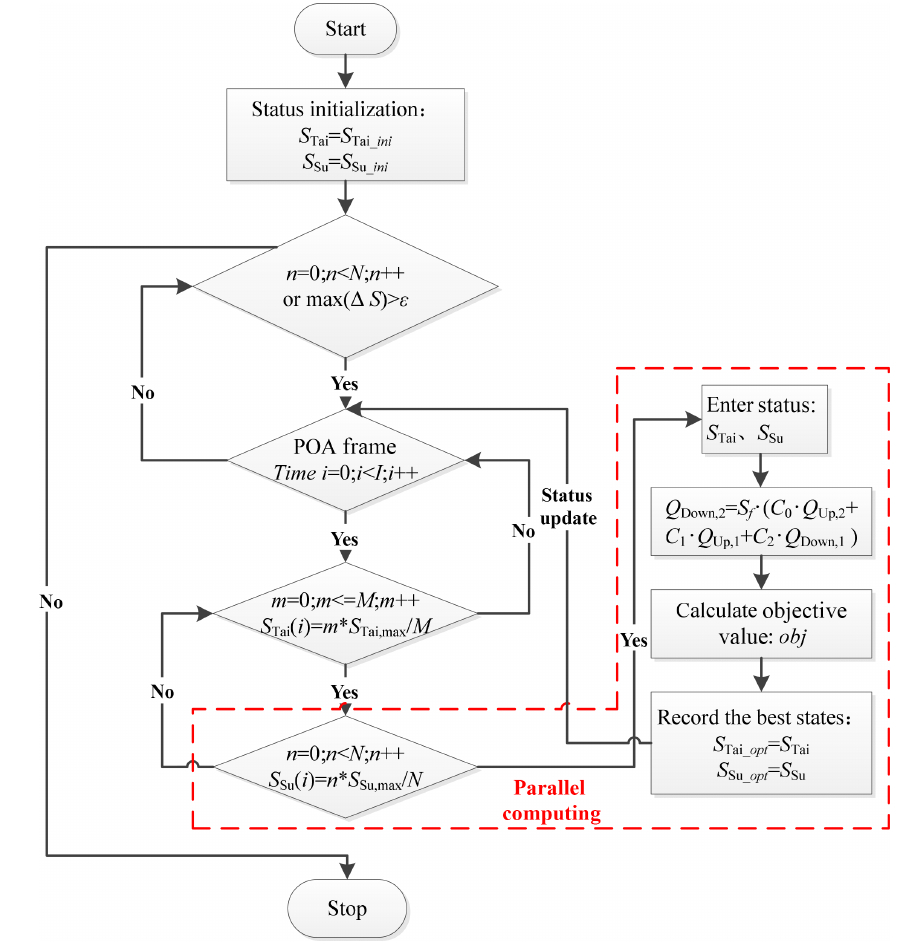
Figure 5. The flow chart of the modeling procedure. Table 3. Analysis of threshold of diversion flow at Taihekou Water Diversion Project and threshold of outflow at Sujiapu Water Diversion Project. Values in bold indicates that Scheme 2 is the best